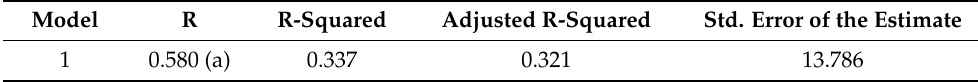
Table A4. Model Summary.